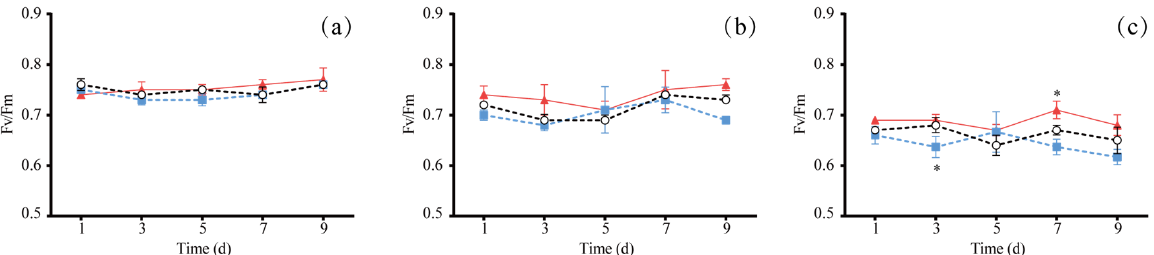
Figure 4. Fv/Fm curves of H. lacustris under light intensities of ( a ) 18 μ mol/m 2 ·s, LL; ( b ) 55 μ mol/m 2 ·s, ML; ( c ) 110 μ mol/m 2 ·s, HL. Treatments are white (open circle), blue (blue box), and red (red triangle) LED lights. Error bars show the standard deviation for three replicates. Asterisks indicate statisti- cally significant differences resulting from t -tests: * p < 0.05.